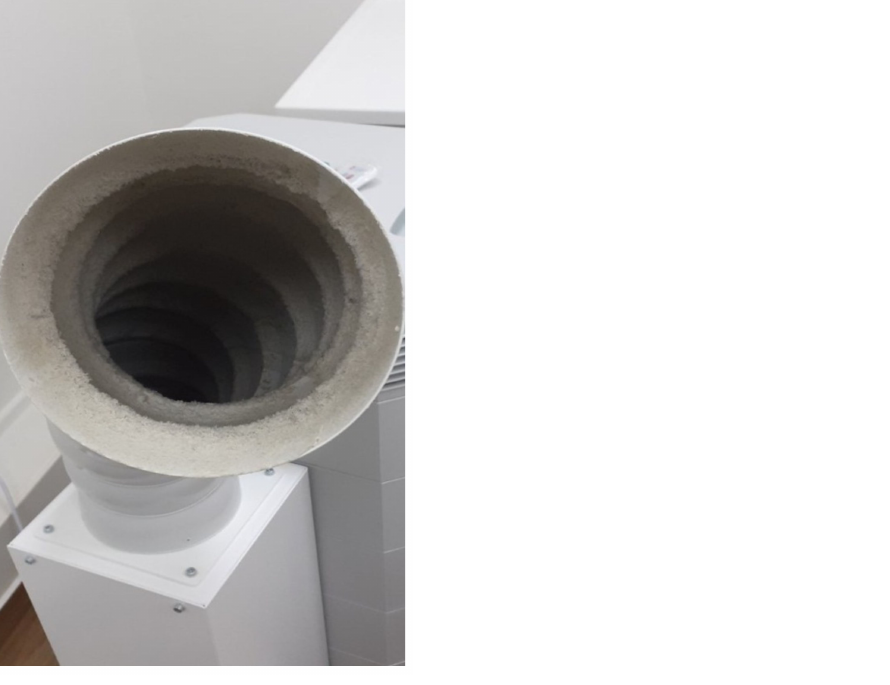
Figure 5. Hose contaminated from microparticles (School of Dentistry, National and Kapodistrian University of Athens).